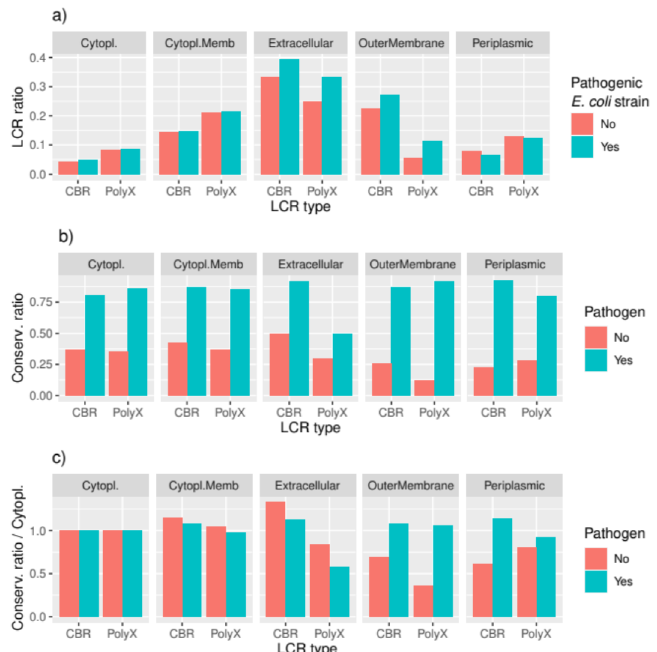
Figure 4. ( a ) CBR and polyX abundance (number of proteins with at least one region versus total number of proteins) per subcellular location and E. coli strain; ( b ) conservation ratio for CBR and polyX regions per subcellular location, taking all pathogenic and non-pathogenic strains together; ( c ) conservation ratio for CBR and polyX regions per subcellular location, normalized by values obtained for cytoplasmic proteins. LCR: low complexity